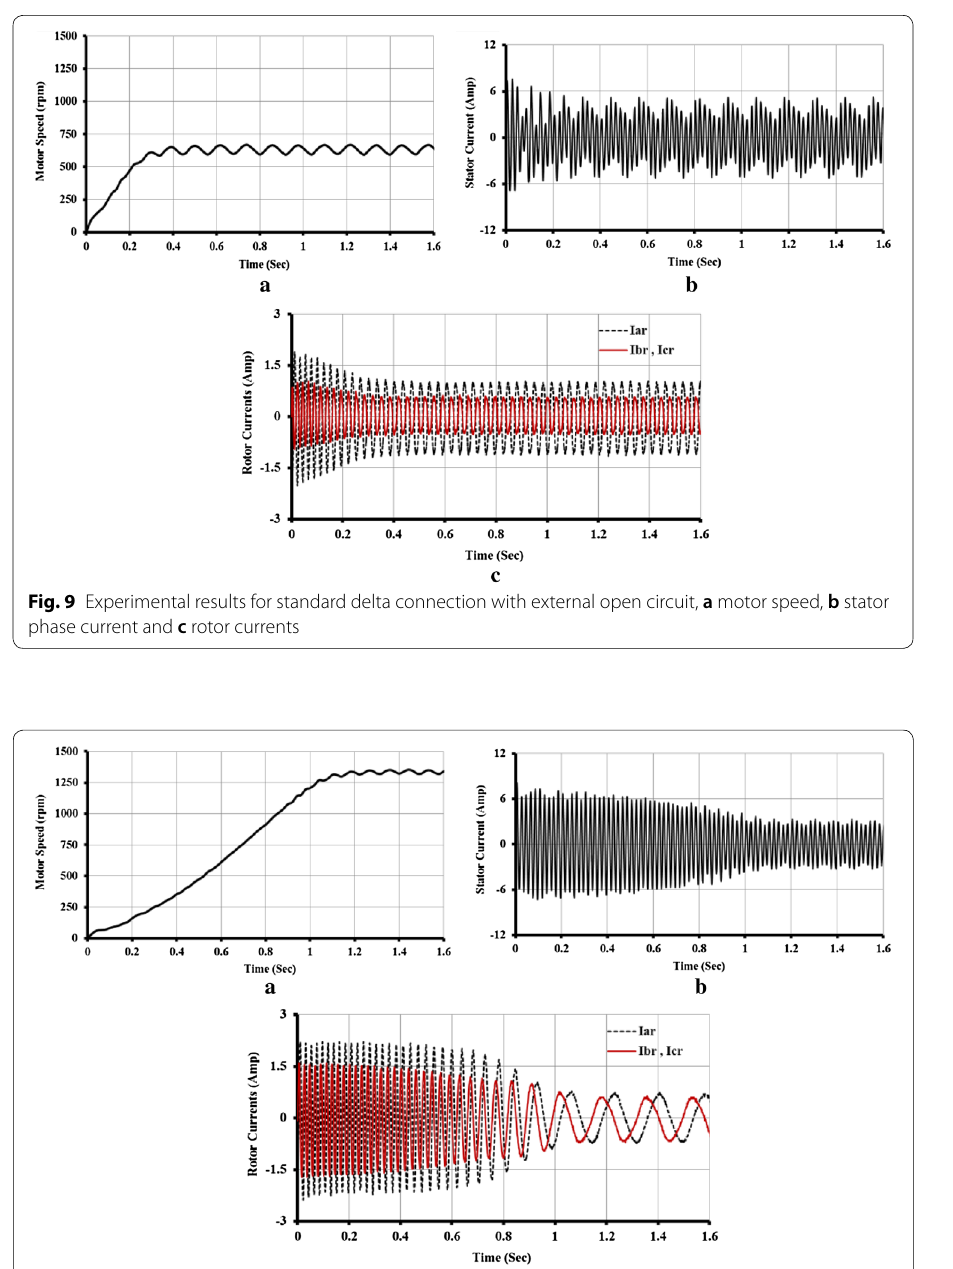
The torque speed curves under healthy and faulty conditions for different connec- tions of rotor windings are measured and plotted experimentally as shown in Fig. 11.